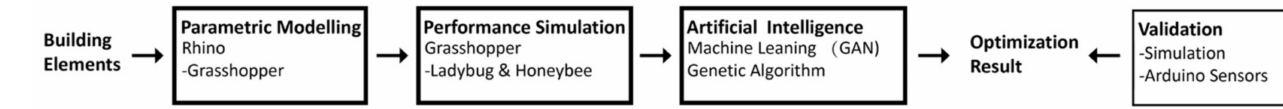
Figure 3. Optimization and validation workflow.